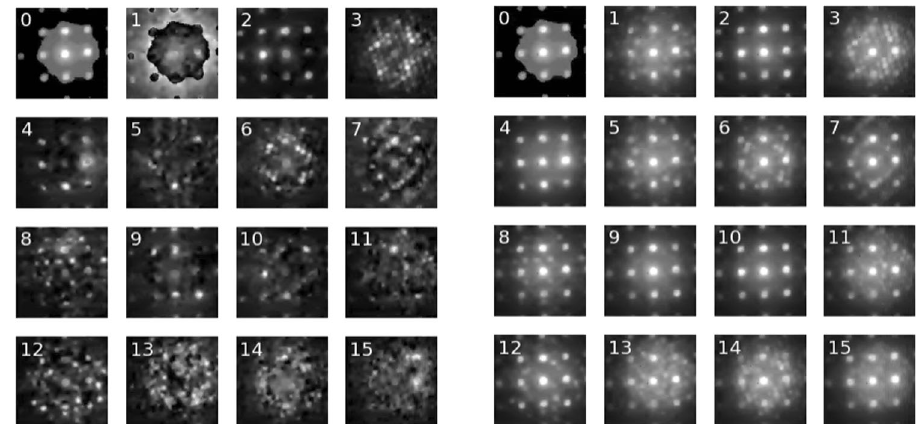
Fig. 12 Comparison between NMF component and centroid pattern. The 16 principal components extracted from the redistributed dataset from the masked precipitates on Al alloy latent-space and the centroid pattern used to represent each component.